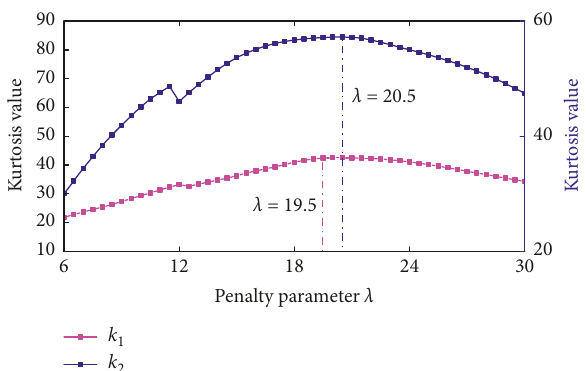
Figure 27: Envelope spectra kurtoses for different values of the regularization